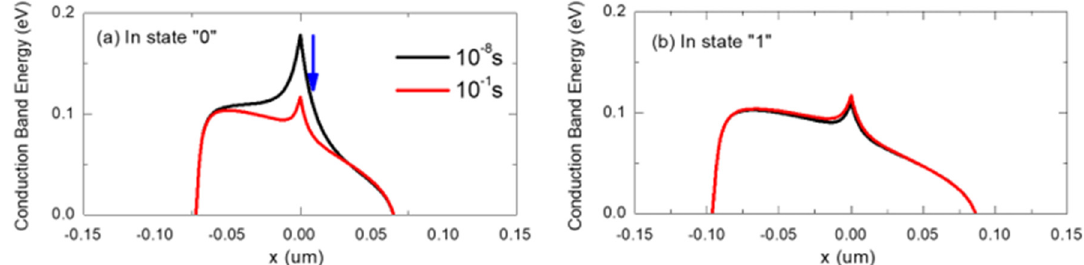
Figure 4. Conduction band energy diagram of poly ‐ Si 1T ‐ DRAM at two hold times (black lines, 10 − 8 s and red lines, 10 − 1 s). ( a ) During the read “0” period and ( b ) during the read “1” period.